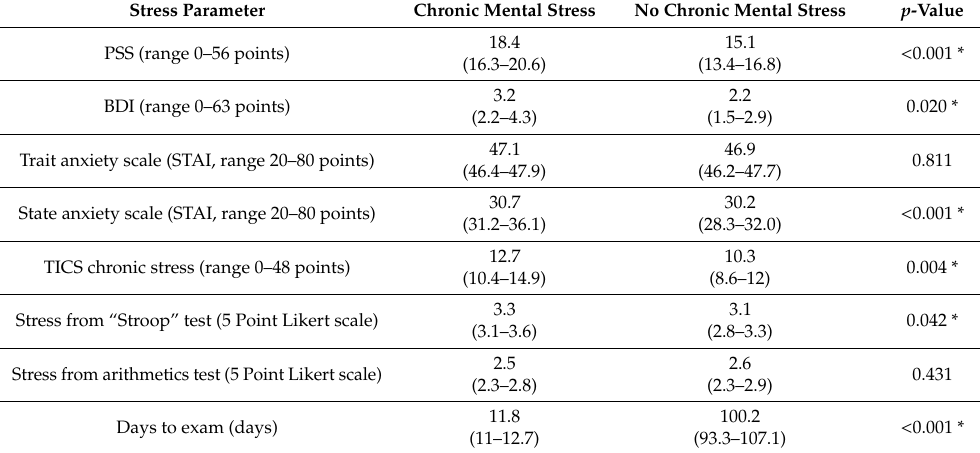
Table 1. Overview of stress related